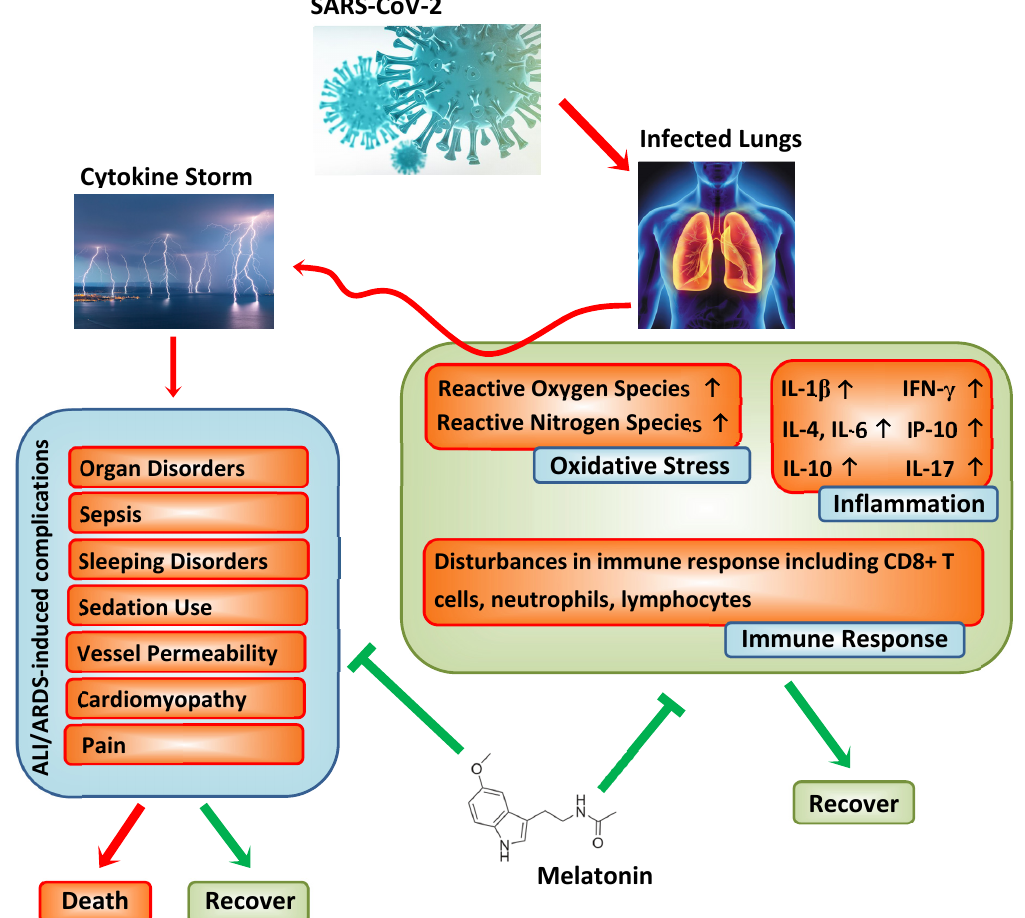
Figure 1. Pathogenesis of SARS-CoV-2 and adjuvant actions of melatonin. We postulate that melatonin significantly suppresses the immune response, the enhanced inflammation, and the excessive oxidative stress, triggering a “cytokine storm”. The “cytokine storm” induces acute lung injury (ALI)/acute respiratory distress syndrome (ARDS) accompanied by severe complications.